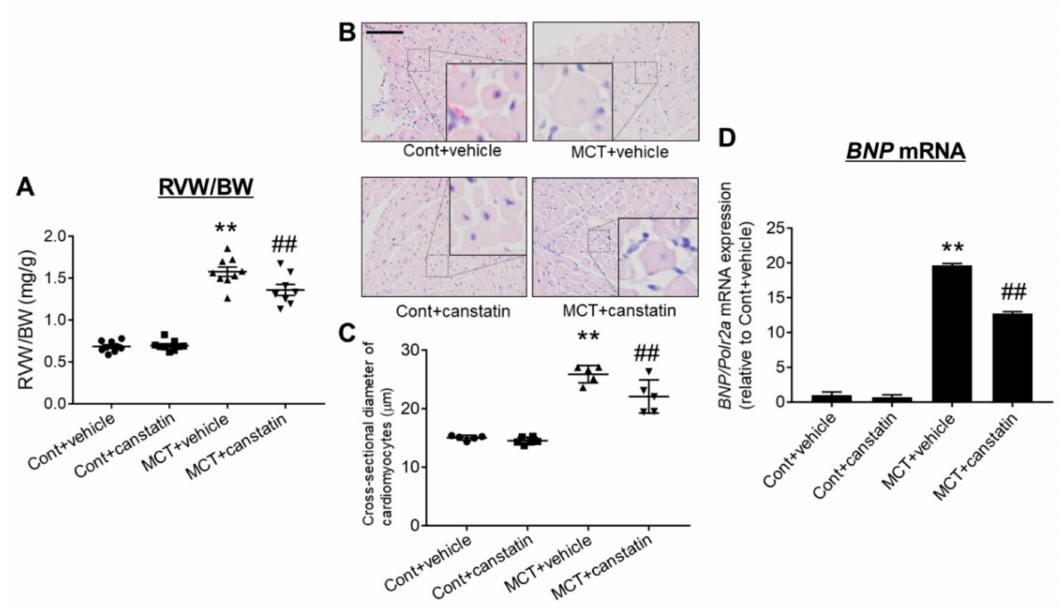
Figure 4. Canstatin improved monocrotaline-induced RV hypertrophy. Four-week-old rats were intraperitoneally injected with saline (Cont) or monocrotaline (60 mg / kg, MCT). Then, vehicle or recombinant mouse canstatin (20 µ g / kg) was intraperitoneally administered for 3 weeks. ( A ) RVW / BW was calculated and is shown as scatter plots of individual data points and mean ± S.E.M. (Cont + vehicle: n = 9, Cont + canstatin: n = 9, MCT + vehicle: n = 9, MCT + canstatin: n = 8). ( B , C ) The RV was isolated and then thin para ffi n section was made. ( B ) Representative HE stained pictures of RV from Cont + vehicle, Cont + canstatin, MCT + vehicle and MCT + canstatin are shown. Scale bar: 100 µ m. ( C ) Cross-sectional diameter of cardiomyocytes was measured and is shown as scatter plots of individual data points and mean ± S.E.M. (Cont + vehicle: n = 4, Cont + canstatin: n = 5, MCT + vehicle: n = 5, MCT + canstatin: n = 5). ( D ) Total RNA was extracted from RV and then complimentary DNA was obtained by reverse transcription. The mRNA expression of brain natriuretic peptide ( BNP ) was measured by quantitative real-time polymerase chain reaction (qRT-PCR) ( ∆∆ CT method). The normalized mRNA expression of BNP relative to Cont + vehicle is shown as mean ± S.E.M. (Cont + vehicle: n = 8, Cont + canstatin: n = 8, MCT + vehicle: n = 9, MCT + canstatin: n = 8). ** p < 0.01 vs. Cont + vehicle, ## p < 0.01 vs. MCT +